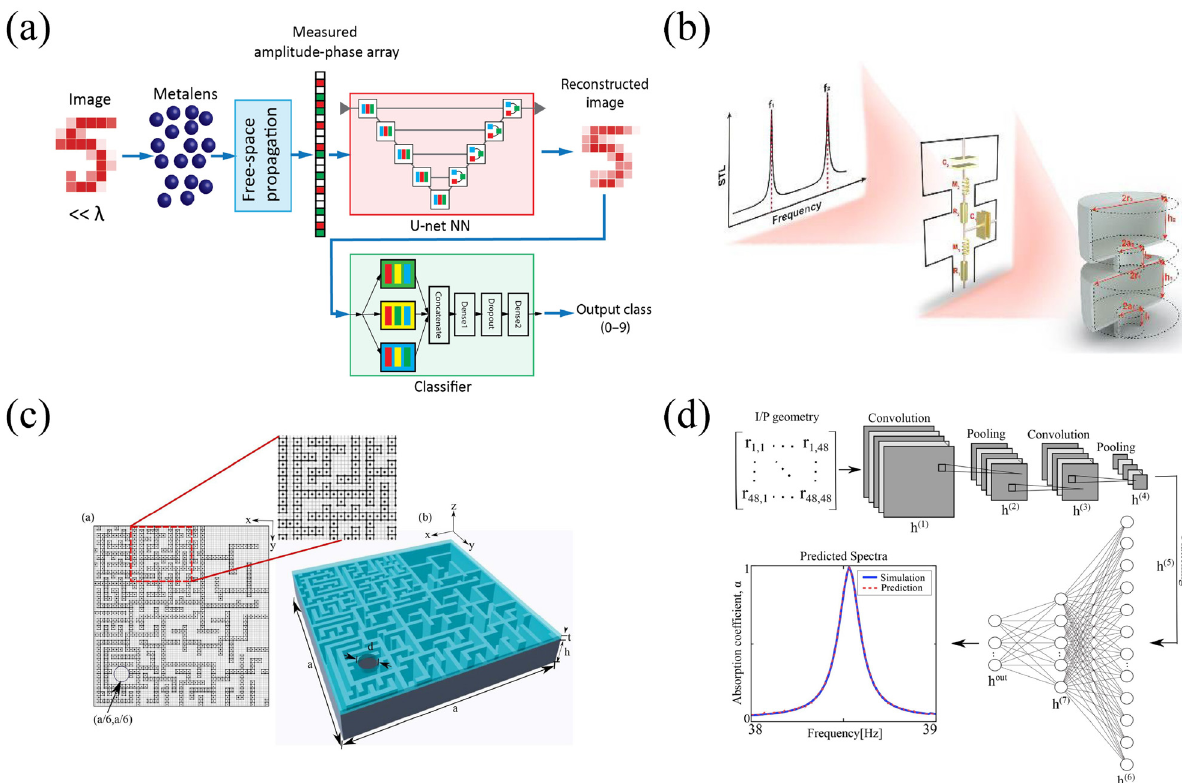
Figure 4: Properties characterization and inverse design of acoustic structure based on deep learning. (a) Breaking the diffraction limit and realizing far-field subwavelength acoustic imaging [99]. (b) Inverse design of multi-order Helmholtz resonators using DNN and LPT [100]. (c) The metasurface absorber and matrix coding [101]. (d) Predicting absorption spectra according to coding matrix by CNN